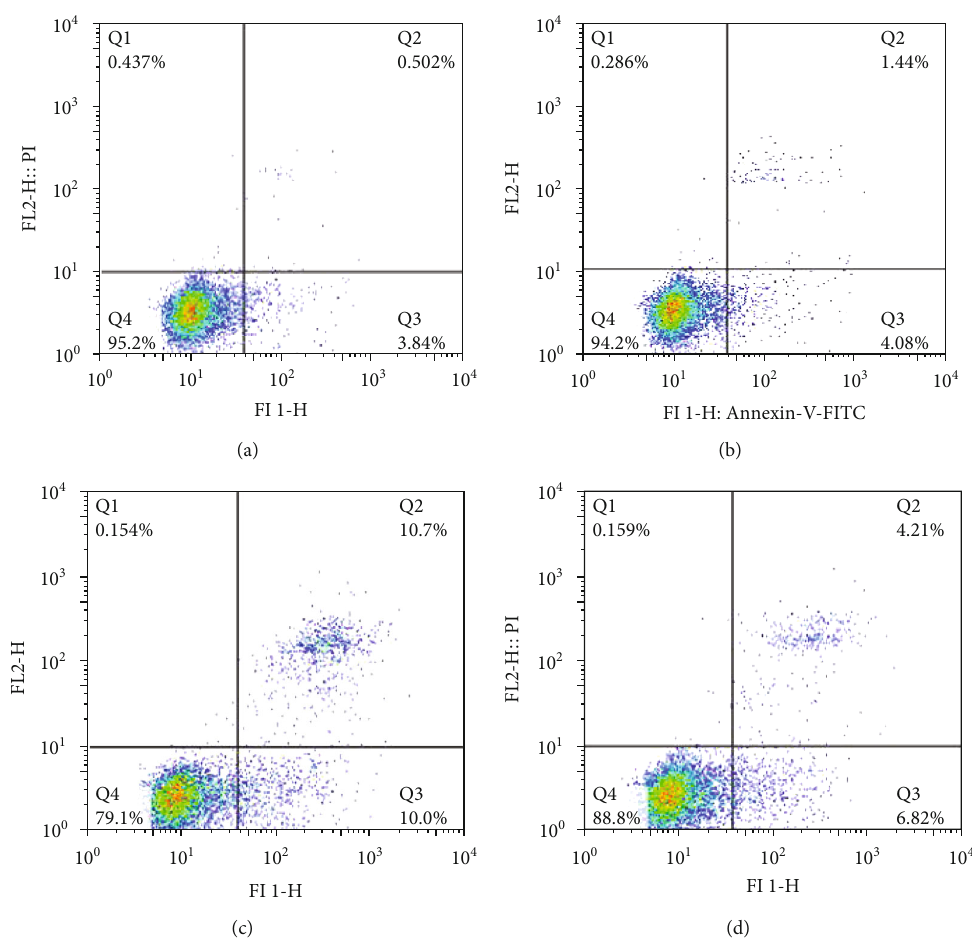
Figure 7: E ff ect of FK506 on podocyte apoptosis. (a) Cellular apoptosis under normal conditions. (b) Podocyte apoptosis of hypertonic group (HM). (c) Cellular apoptosis in the high glucose-treated group (HG), and (d) after using FK506, apoptotic podocyte counting was signi fi cantly decreased in the FK506